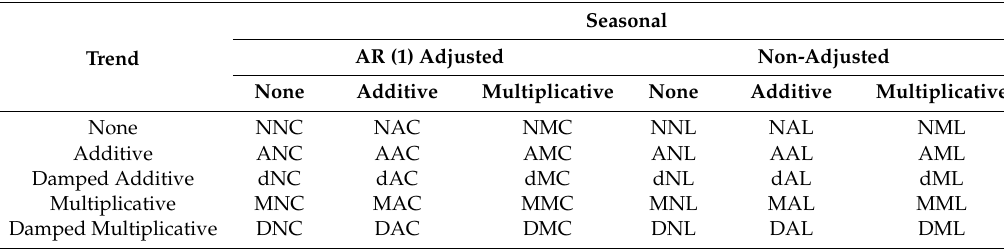
Table 1. Multiple seasonal Holt–Winters models’ nomenclature according to the trend and seasonal